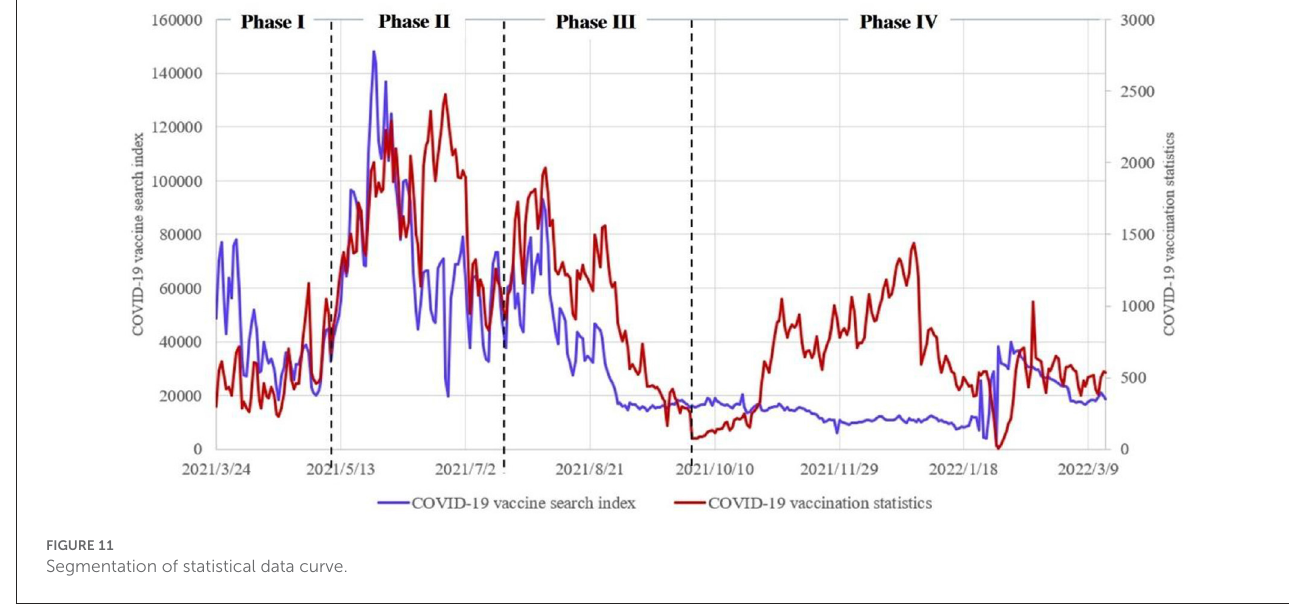
FIGURE11 Segmentation of statistical data curve.